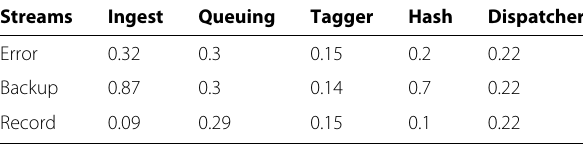
Table 4 Heterogeneous events labeling (seconds)